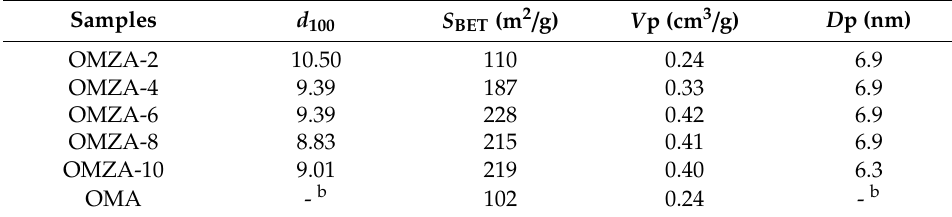
Figure 9. N 2 sorption isotherms ( a ) and pore size distribution curves ( b ) of samples OMZA-x and OMA after thermal treatment at 1000 °C for 1 h. For clarity, in ( a ), the isotherms of OMZA-4, OMZA- 6, OMZA-8, OMZA-10 and OMA are offset along the Y axis by 160, 370, 560, 710 and 950 cm 3 /g, respectively. In ( b ), the Y axis values are increased by 2, 4.2, 7.5, 10.8 and 13.8 cm 3 /g, respectively. Table 2. The textural properties of OMZA-x and OMA thermally treated at 1000 °C for 1 h. a